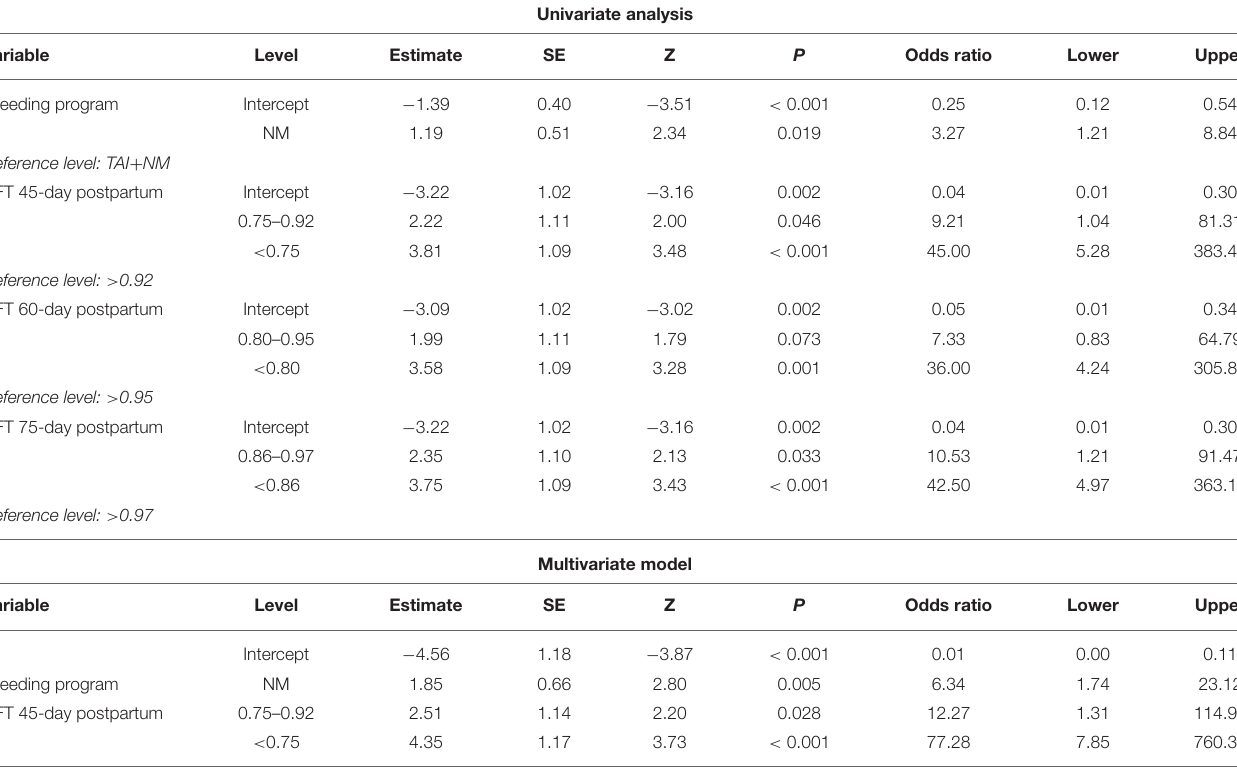
Univariate analysis